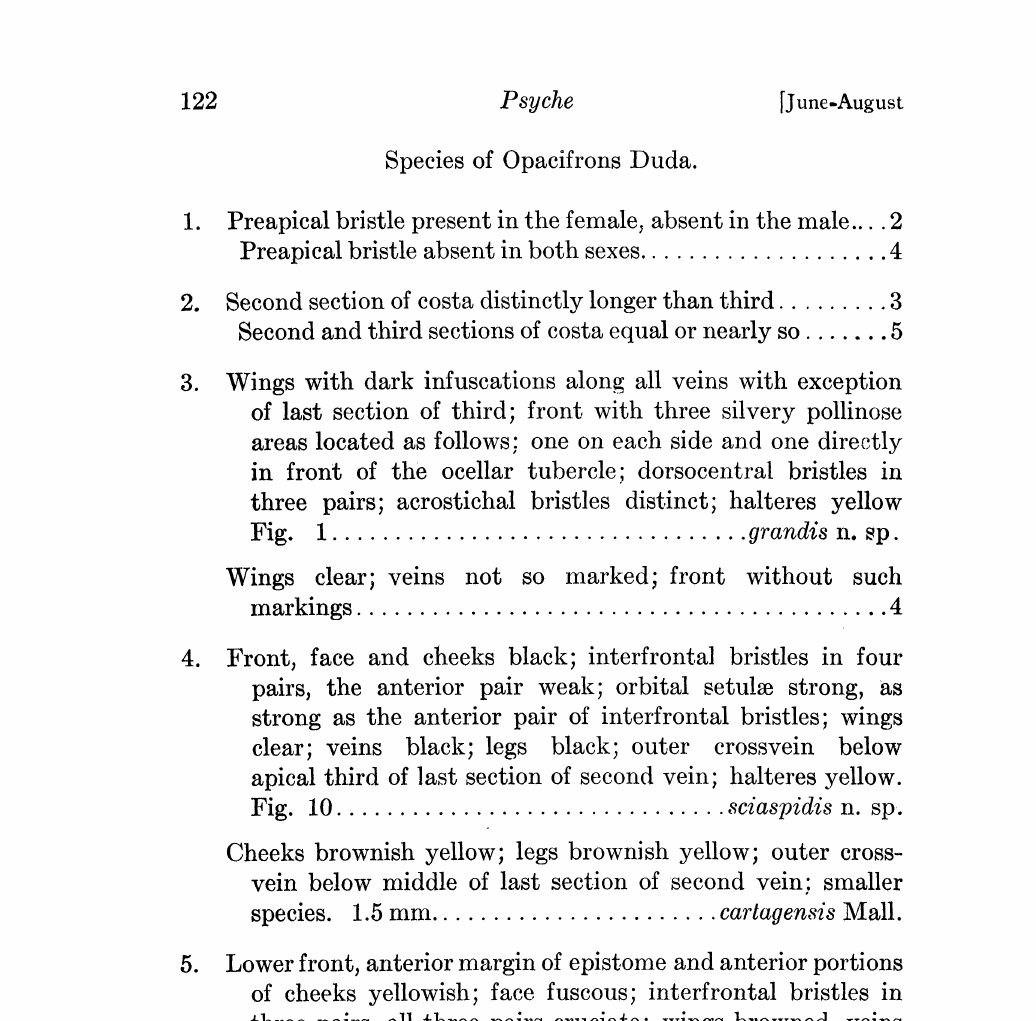
Fig. 6. cadobata n. sp.